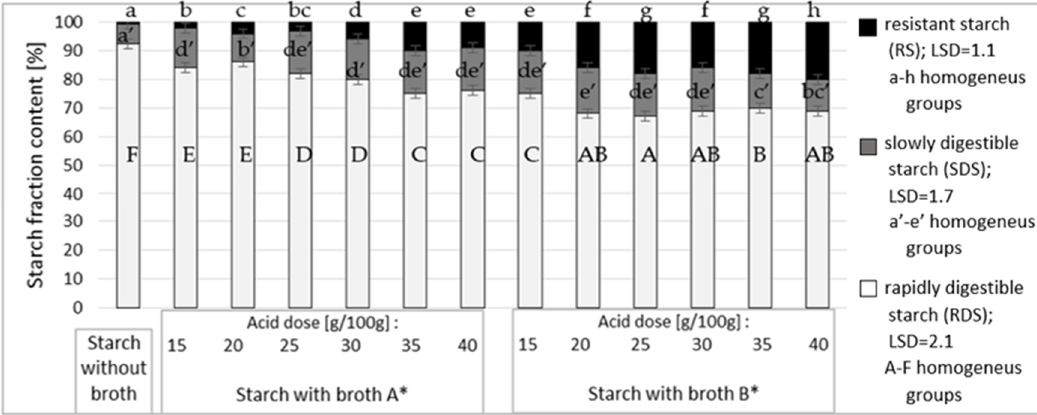
Figure 3. Effect of acid dose on the resistance of starch esters. * Broth A— α -ketoglutaric acid 60 g/L; citric acid 18 g/L; pyruvic acid 1 g/L; Broth B— α -ketoglutaric acid 49 g/L; citric acid 46 g/L; pyruvic acid 1.5 g/L.